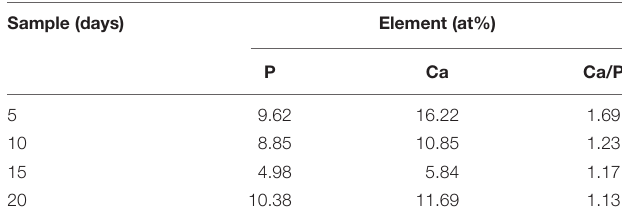
TABLE 4 | Ca and P contents on coating surface after different immersion